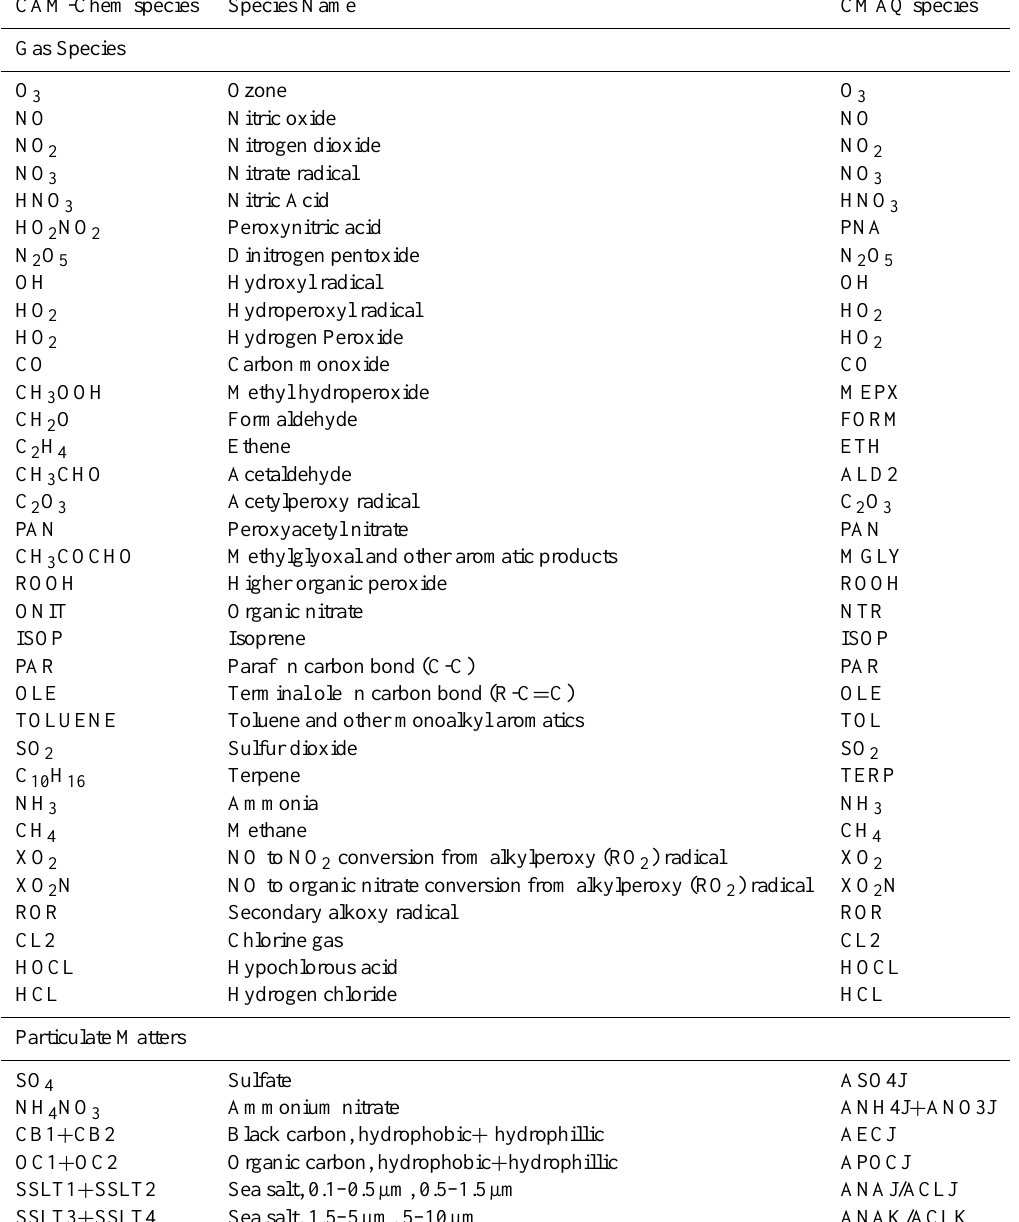
Table 1. Mapping table between CAM-Chem and CMAQ. CAM-Chem